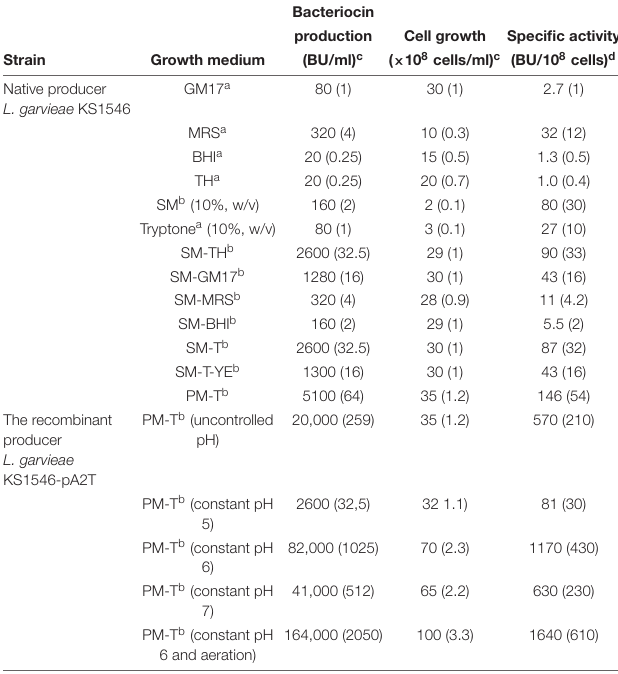
The bacteriocin activity and cell growth from complex growth media (a) and milk basedmedia(b)weremeasuredafter7and9hofincubation,respectively. c :Values are average of triplicate assays, numbers in parentheses are fold increased or decreased in relation to the value in GM17. d : numbers in parentheses are fold increased or decreased in relation to the value in GM17.